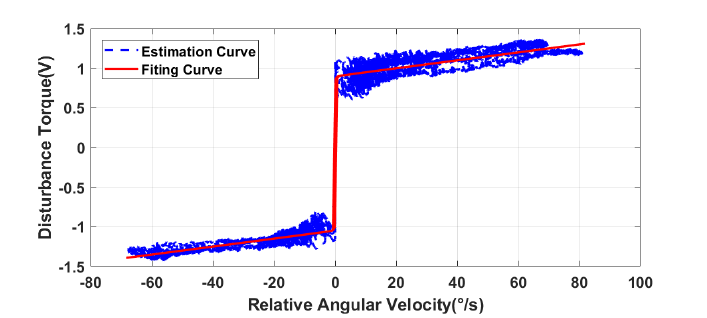
Figure 7. Disturbance torque fitting and the estimation values.